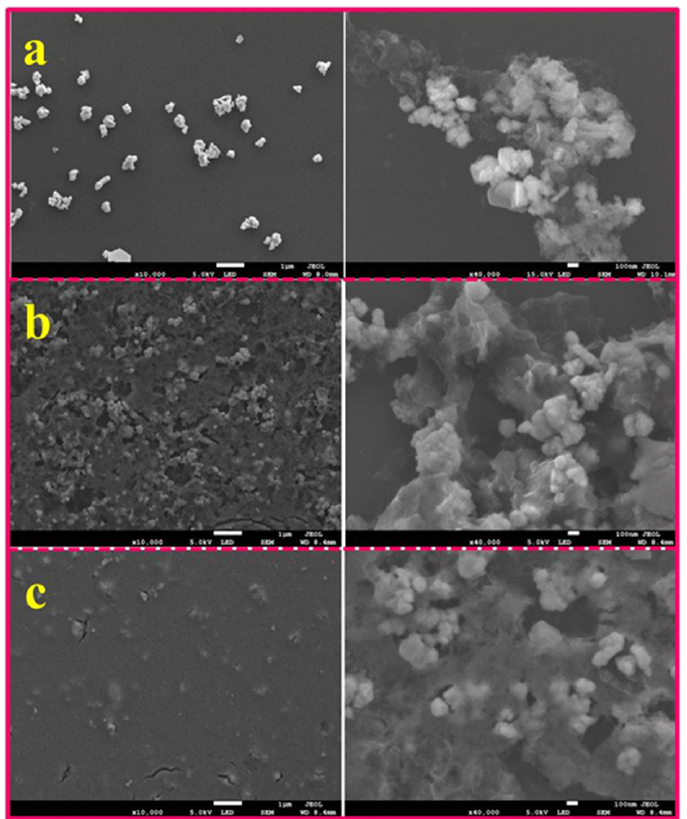
Figure 3. ( a – c ) The SEM images of the superstructure TaS 2 nanoparticles assembled with different thicknesses were obtained for 1 μ m scale bar on the SPR chip surface. The panels on the right side are the magnified images, with a scale bar of 100 nm.